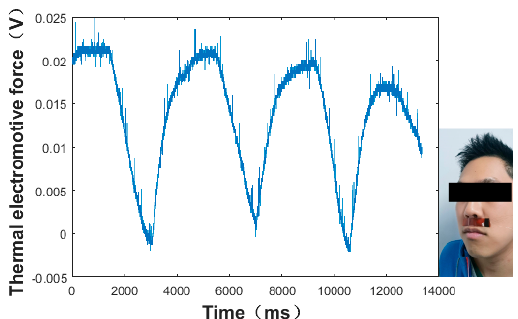
Figure 15. Test results of the normal respiration of the flexible thermocouple film sensor in a cycle.